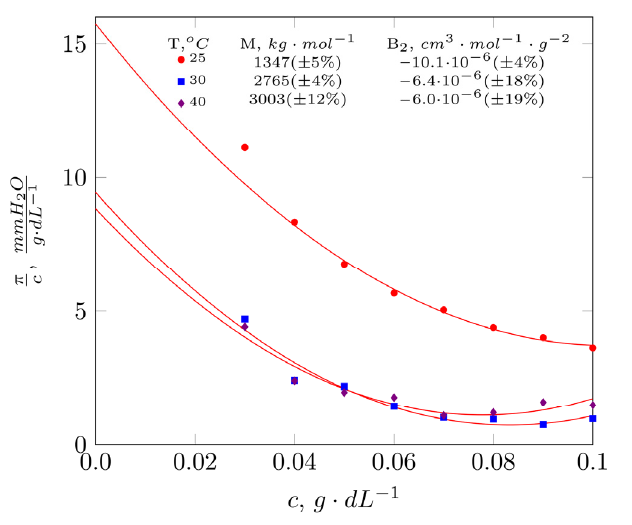
Table 1. Osmotic and hydrodynamic parameters of raw Plantago ovata husk extracts.